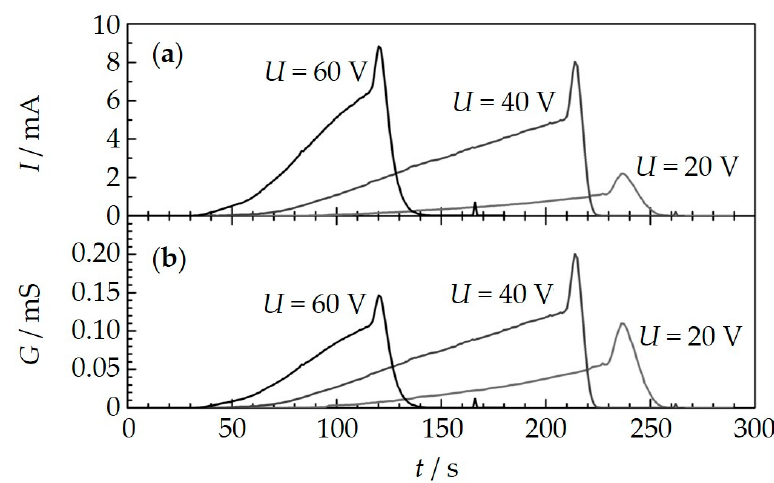
Figure 4. Raw data I ( t ) (( a ) and calculated conductance data G ( b ) for three measurement cycles (soot collection with different voltages and subsequent regeneration) under similar conditions (soot concentration = 17 mg/m 3 ). The curves are shifted to a common starting time that is the end of the prior regeneration phase.